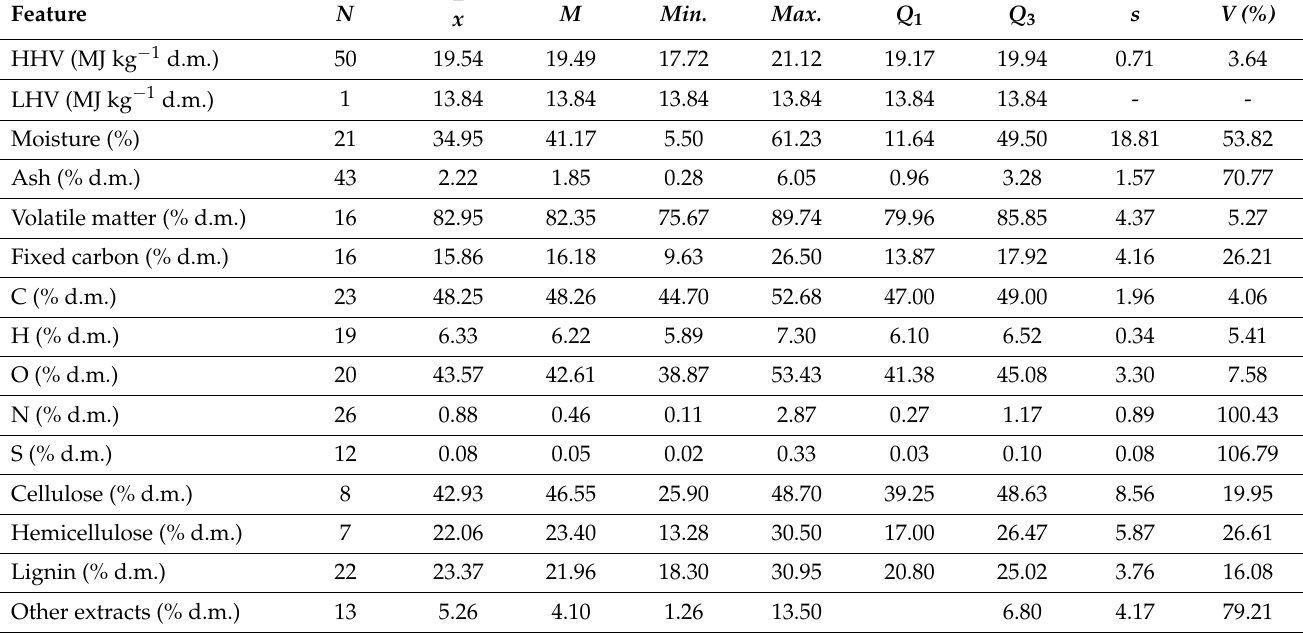
Table 6. Differentiation of thermophysical properties and elemental composition of deciduous